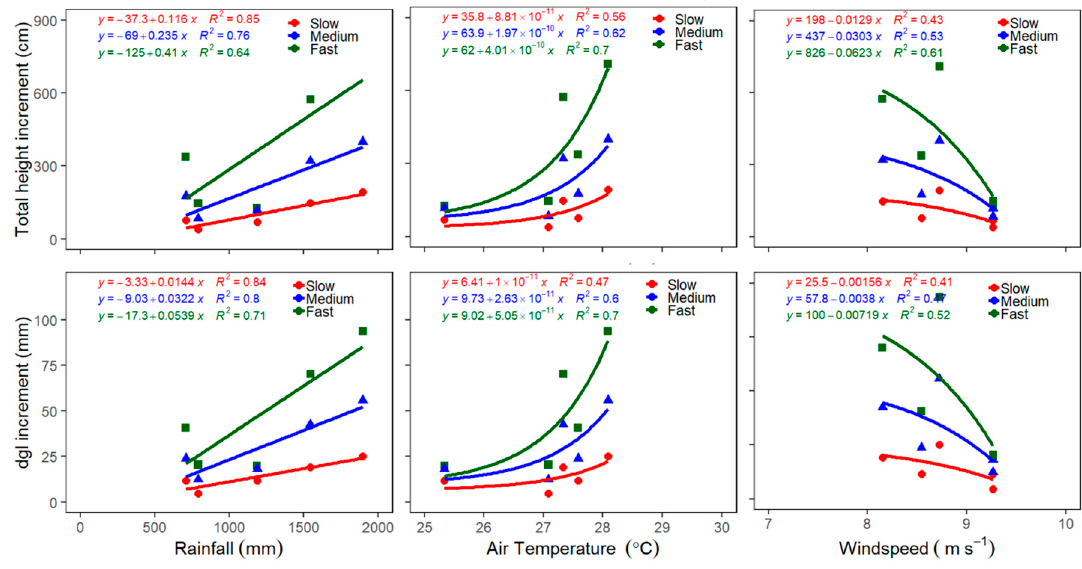
Figure 8. Relationship between annual total height and dgl increments with annual rainfall and annual averages of air temperature and wind speed. Each colored symbol represents the average annual data of all species clustered into slow, medium, and fast categories.